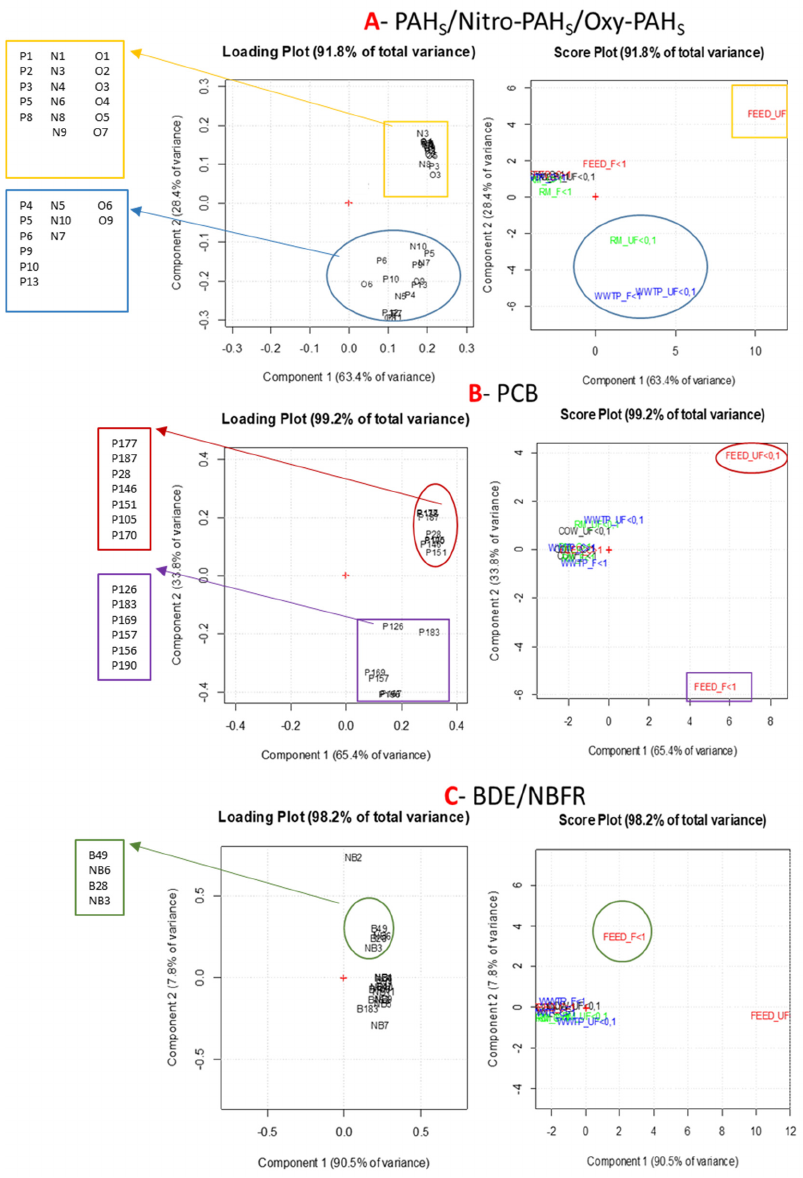
Figure 7. Loading and score plots of PCA carried out on the three classes of compounds: PAHs and derivatives ( A ), PCBs ( B ), PBDE and NBFR ( C ). Compound codes, listed in the side frames, are identified in the Supplementary Materials (Table S1).